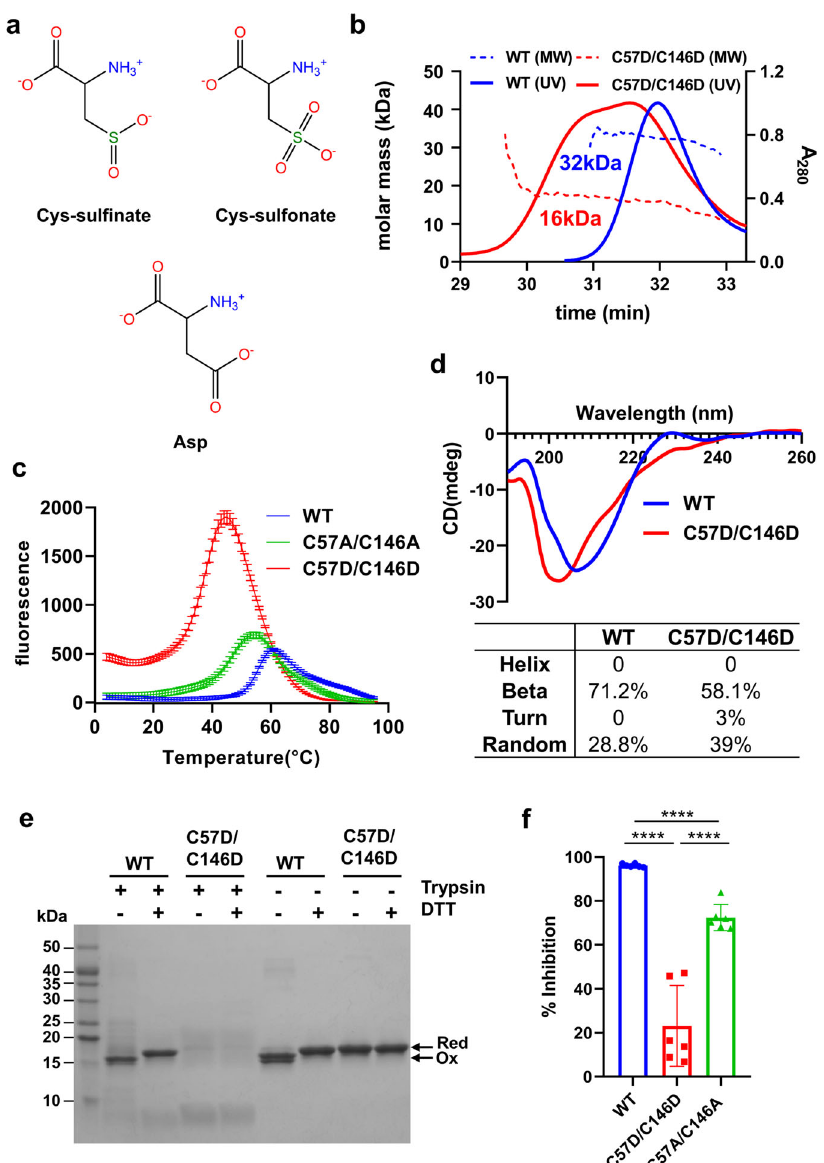
Fig. 1 Effect of the C57D/C146D mutation on the biochemical properties of puri fi ed SOD1 proteins. a Structural comparison of cysteine-sul fi nic acid and cysteine-sulfonic acid to aspartic acid. Cysteine-sul fi nic acid and -sulfonic acid are the overoxidized forms of cysteine in the presence of ROS. Note that aspartic acid mimics Cys-sul fi nic acid and Cys-sulfonic acid in terms of the electrostatic charge and the atomic arrangement. Detailed descriptions are in Supplementary Fig. 1. b SEC-MALS pro fi les of the puri fi ed wild-type (blue) and C57D/C146D mutant (red) SOD1 proteins. The UV absorbance at 280nm (A 280 at the right Y-axis) of the SEC is represented by solid lines. The molecular mass (the left Y-axis) based on MALS is represented by a dotted line. The average molar mass of wild-type or C57D/C146D mutant SOD1 is indicated under the dotted lines. c Tm measurement by the thermal shift assay of the wild-type SOD1 protein (WT, blue line), C57A/C146A mutant SOD1 protein (green line), and C57D/C146D mutant SOD1 protein (red line). Individual raw data points displayed for each temperature represented the average of three endpoint readings with ±SD. According to the analyzing results (Supplementary Fig. 2c), the Tm values of the wild-type, C57A/C146A, and C57D/C146D were 56°C, 47°C, and 38°C, respectively. d Top , far-UV CD spectra of the wild- type SOD1 (WT, blue line) and C57D/C146D mutant SOD1 (red line) at the wavelength range of 190-260 nm. Bottom , the estimated secondary structure of wild-type and mutant protein calculated based on CD spectra. The proportion of each secondary structure constituting the SOD1 protein is expressed as a percentage. e Proteolytic digestion of the wild-type (WT) and C57D/C146D mutant SOD1 proteins by trypsin. The proteins were digested at 37°C for 1 h in the presence or absence of 5mM DTT and then subjected to SDS-PAGE. The redox states of SOD1 proteins are indicated by arrows to the right of the SDS polyacrylamide gel image. All the cysteines in SOD1 are reduced (red), or an intramolecular bond is formed between Cys57 and Cys146 (Ox). f Relative superoxide dismutase activities of the wild-type (blue), C57D/C146D (red), and C57A/C146A (green) mutant SOD1 protein. Inhibition of cytochrome c reduction by superoxide in the presence of SOD1 was represented in bar graphs with mean ± SD from six individual experiments. Statistical comparisons were performed using an unpaired two-tailed Student ’ s t -test. Differences were considered statistically signi fi cant at P -values < 0.05. **** denote p < 0.0001. Raw data are presented in Supplementary Fig. 2e.